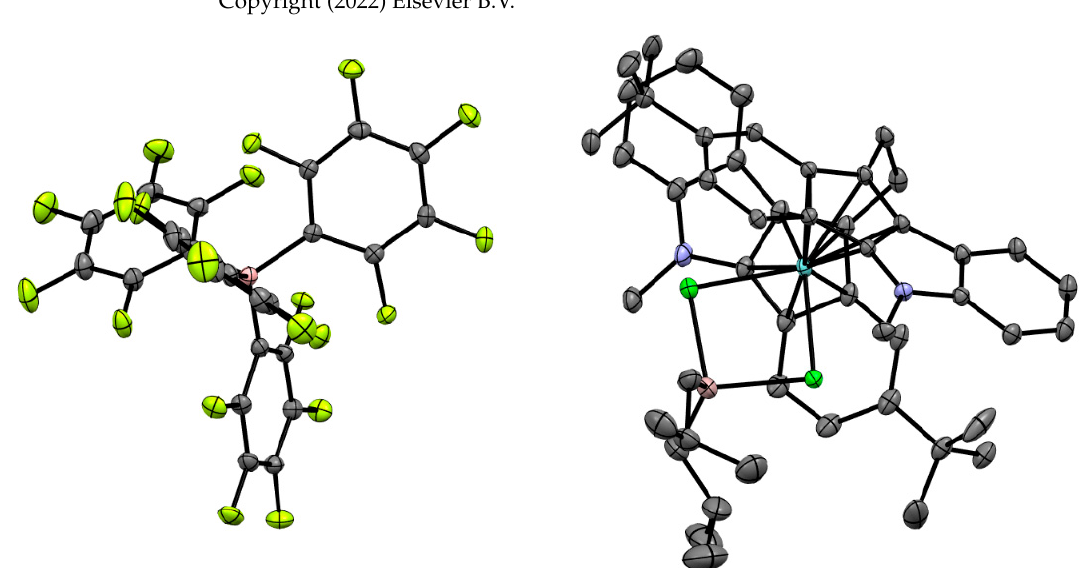
Figure 23. Schemes follow the same formatting. Reprinted with permission from [43]. Copyright (2022) Wiley-VCH Verlag GmbH & Co. Copyright (2016) Royal Society of Chemistry. Copyright (2012) American Chemical Society. Copyright (2015) Springer Nature. Copyright (2019) Elsevier